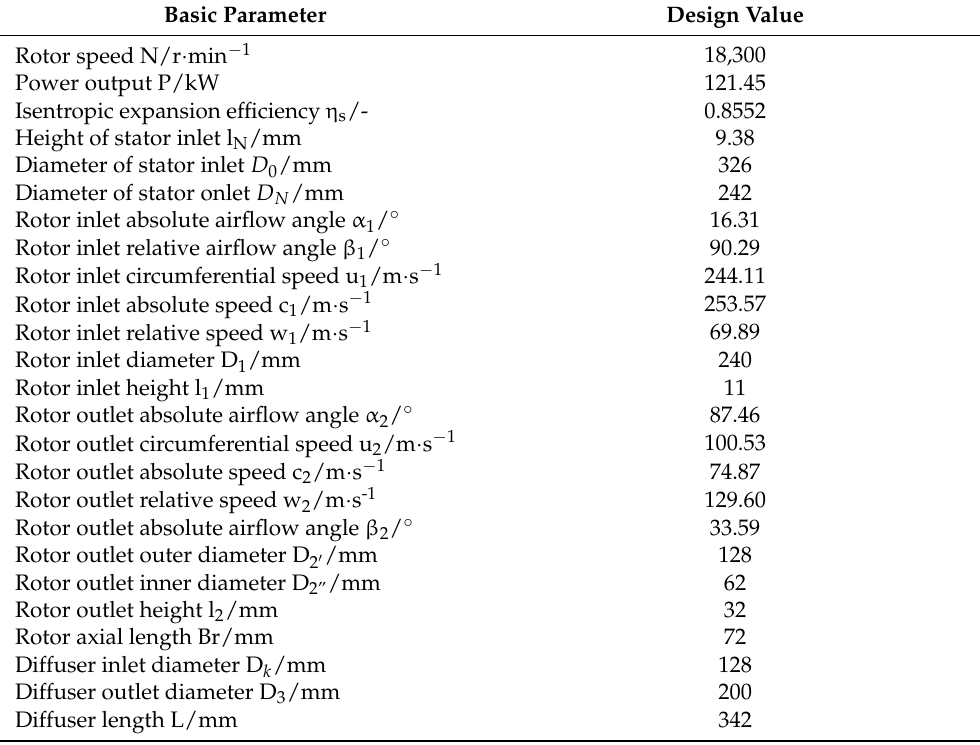
Table 3. Initial aerodynamic design